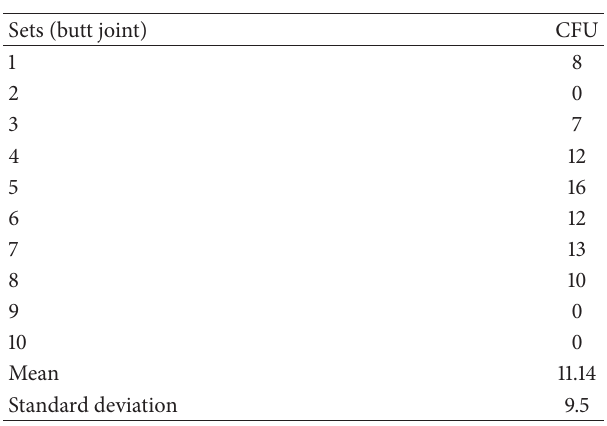
Table 1: Assessment of bacterial growth in butt joint connection group.